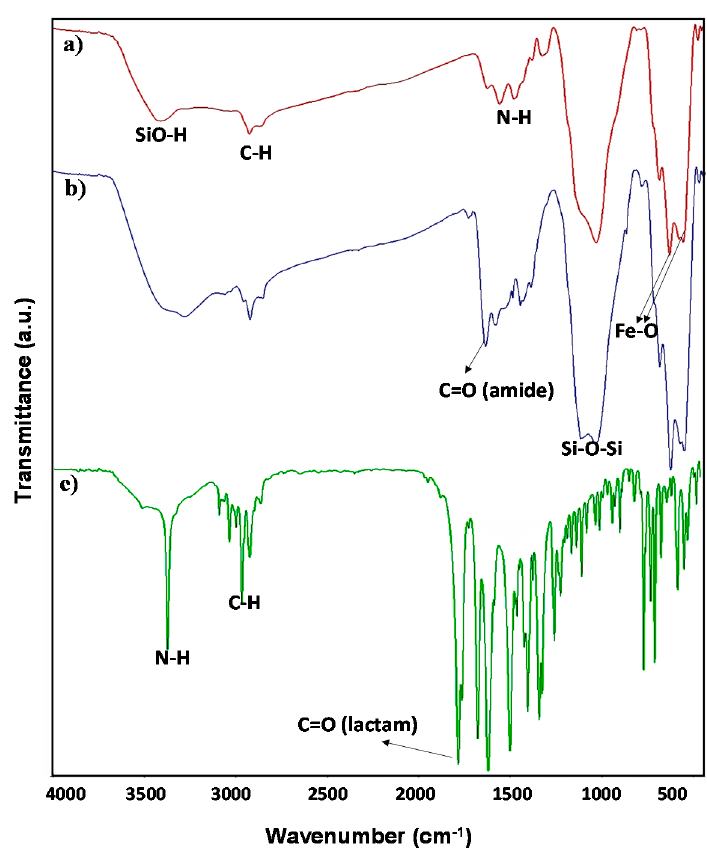
Figure 4. FT-IR spectra of ( a ) γ -Fe 2 O 3 @SiO 2 -NH 2 , ( b ) Prn/Fe 2 O 3 @SiO 2 , and ( c ) penicillin G.